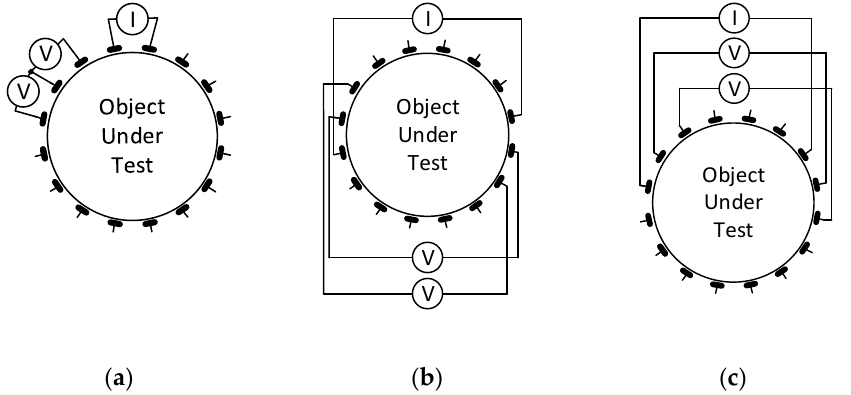
Figure 1. The initial procedural steps in two current pattern sequences for tomographic measure- ment: ( a ) adjacent; ( b ) opposite; ( c ) skip-5. ( a ) adjacent; ( b ) opposite; ( c )